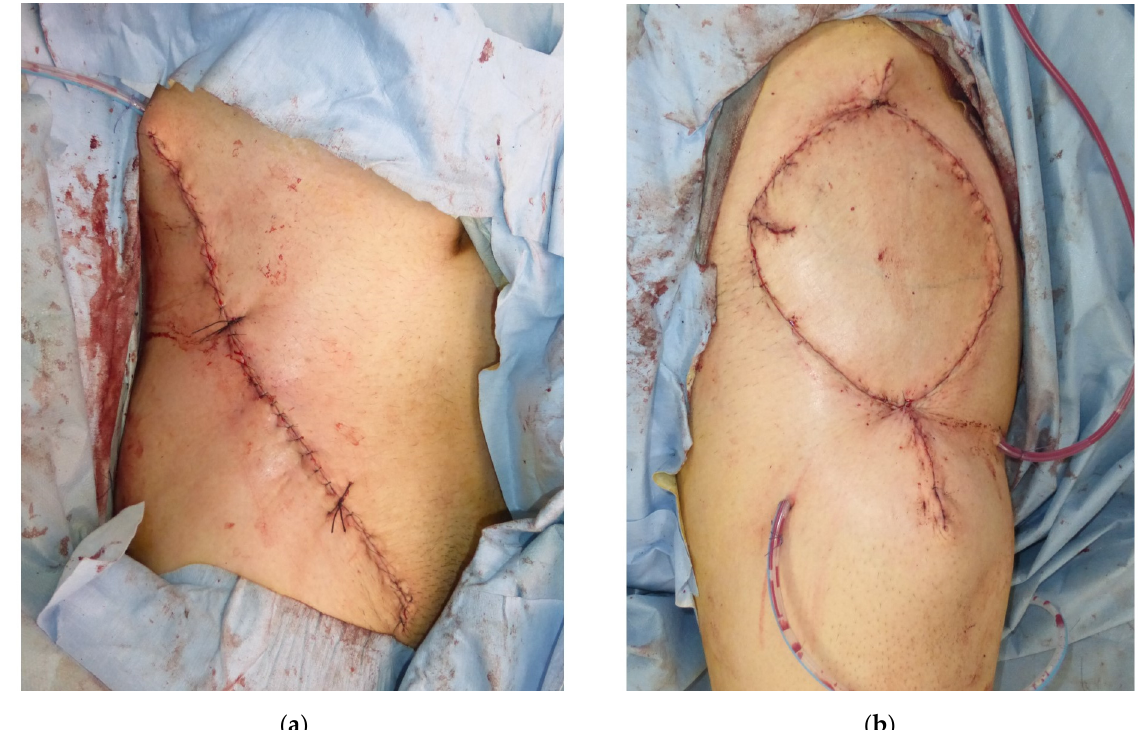
Figure 4. The immediate postoperative views. ( a ) The donor site was closed directly over a suction drain; ( b ) the flap was transferred to the defect.